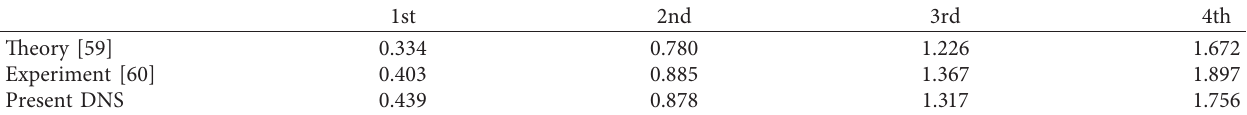
Table 1: Comparison of Strouhal numbers with the theoretical and experimental